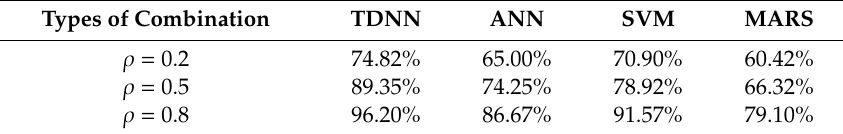
Table 11. The average AIRs of the four classifiers for an MNP 9